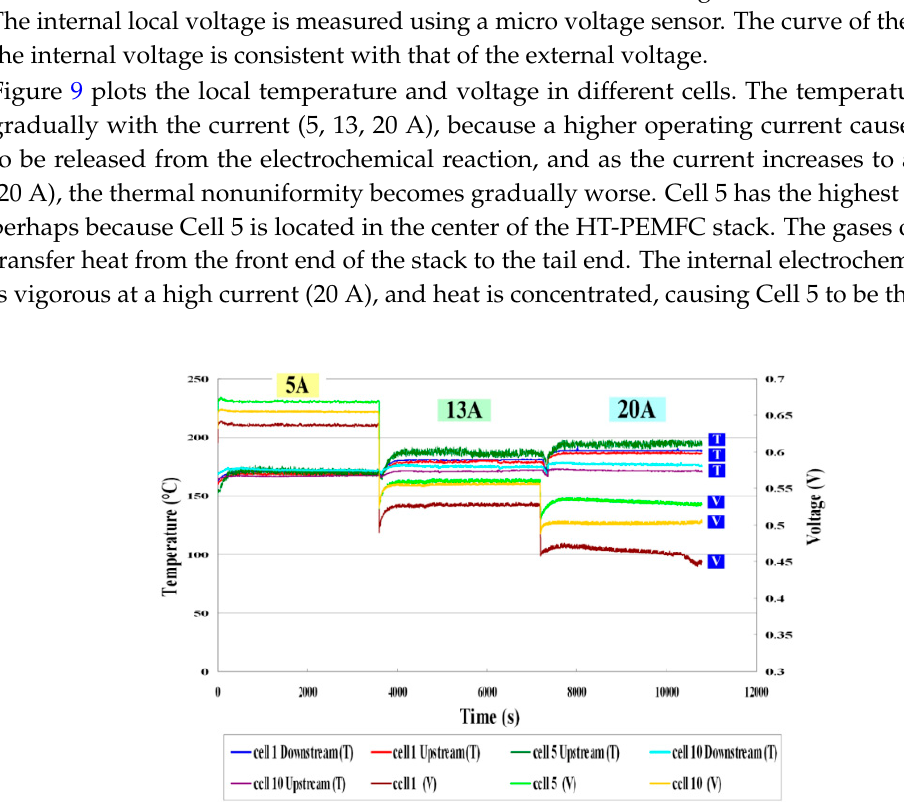
Figure 10. Comparison of local temperatures and voltages in different cells. Figure 9. Comparison of local temperatures and voltages in different cells.